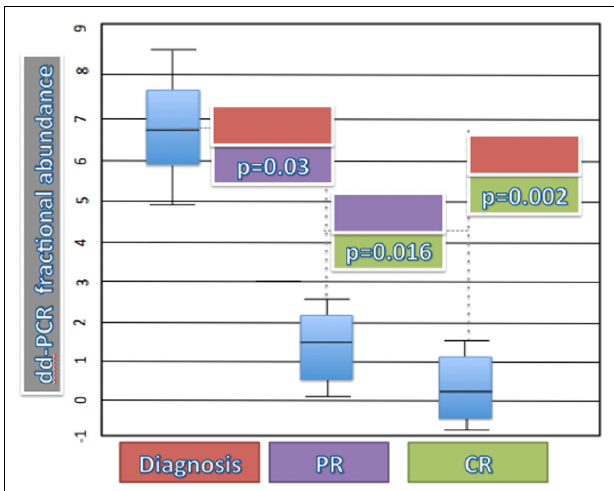
FIGURE 3 | T -test for dd-PCR fractional abundance and status of disease. Diagnosis (red box) vs. PR (violet box): p = 0.03; diagnosis (red box) vs. CR (green box): p = 0.002; PR (violet box) vs. CR (green box): p =